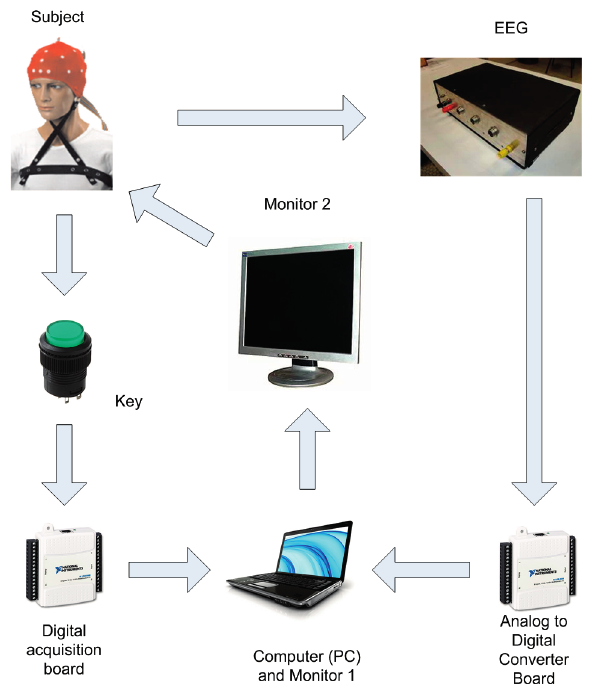
Figure 2. Block diagram of the proposed experiment.